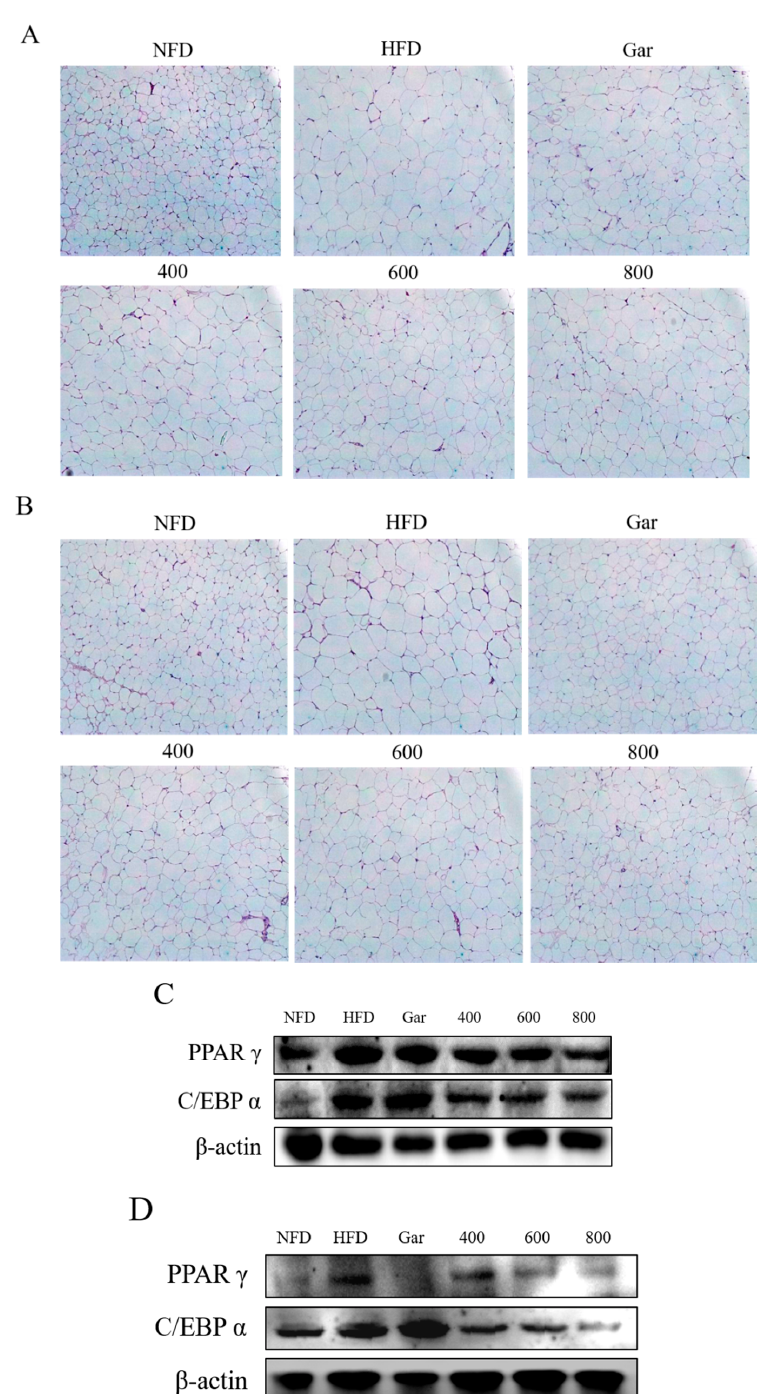
Figure 6. ( A ) Histological change of abdominal fat tissue. ( B ) Histological change of epididymal fat tissue. H&E stained sections of fat tissues were observed with an optical microscope at × 400 (Axiovert 100, Germany). ( C ) The expression of PPAR γ , C / EBP α , and β -actin in abdominal fat tissue was analyzed by Western blot analysis. ( D ) The expression of PPAR γ , C / EBP α , and β -actin in epididymal fat tissue was analyzed by Western blot analysis. NFD; Normal-Fat Diet. HFD; High-Fat Diet. Gar; Garcinia 245 mg / kg / day. 400; The ethanol extract of Cheongchunchal (CE) 400 mg / kg / day. 600; CE 600 mg / kg / day. 800; CE 800 mg / kg /